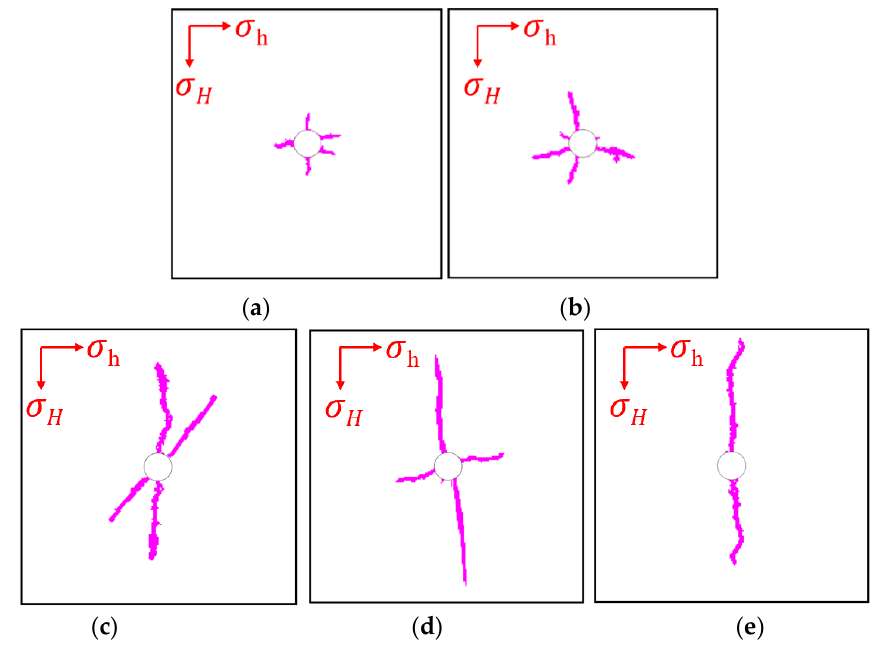
Figure 9. Numerical simulation results when injecting supercritical carbon dioxide under various stress states. ( a ) σ H - σ h = 0; ( b ) σ H - σ h = 1 MPa; ( c ) σ H - σ h = 2 MPa; ( d ) σ H - σ h = 3 MPa; ( e ) σ H - σ h = 4 MPa.